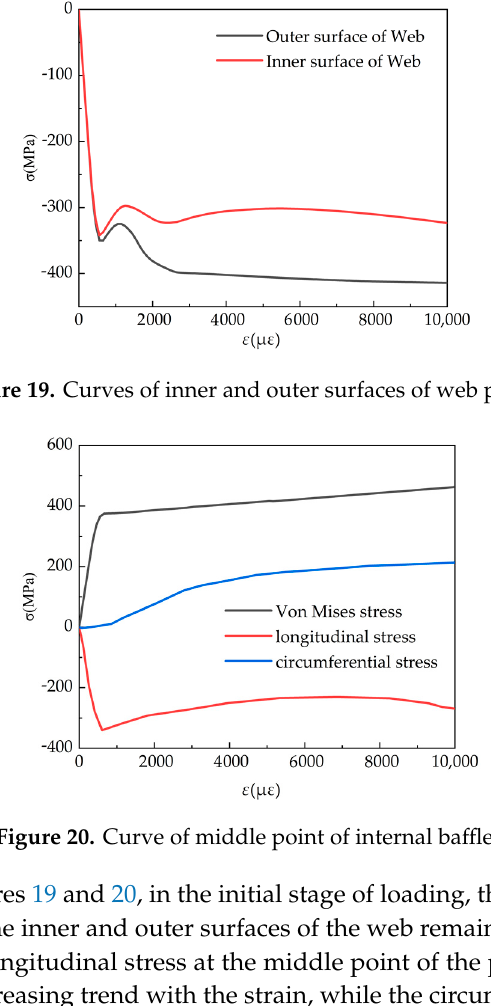
Figure 18. Position of each characteristic point (H/2) of multi-cavity steel tube section.